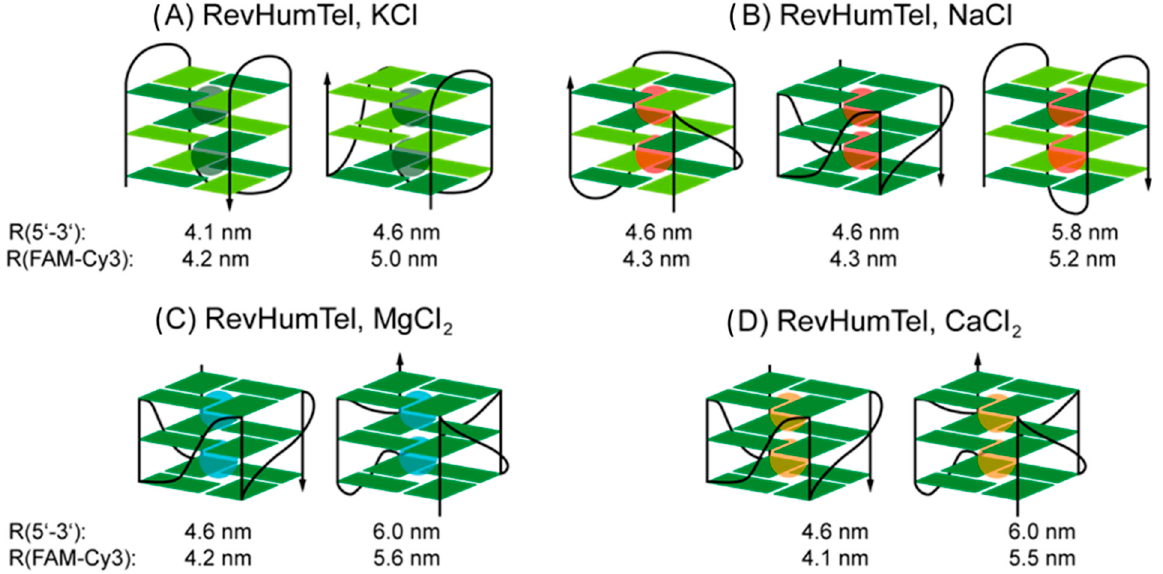
Figure 3. G-quadruplex structures for RevHumTel in presence of different salts ( A ) KCl, ( B ) NaCl, ( C ) MgCl 2 and ( D ) CaCl 2 . The G-quadruplex structures have been determined based on CD spec- troscopy and FRET measurements. Dark green rectangles represent antiglycosidic angles for G and light green syn orientation. Table 1. Summary of G-quadruplex structures and conformation attained by RevHumTel in presence of different salts based on the theoretical and experimental values obtained from FRET and CD results as tabulated